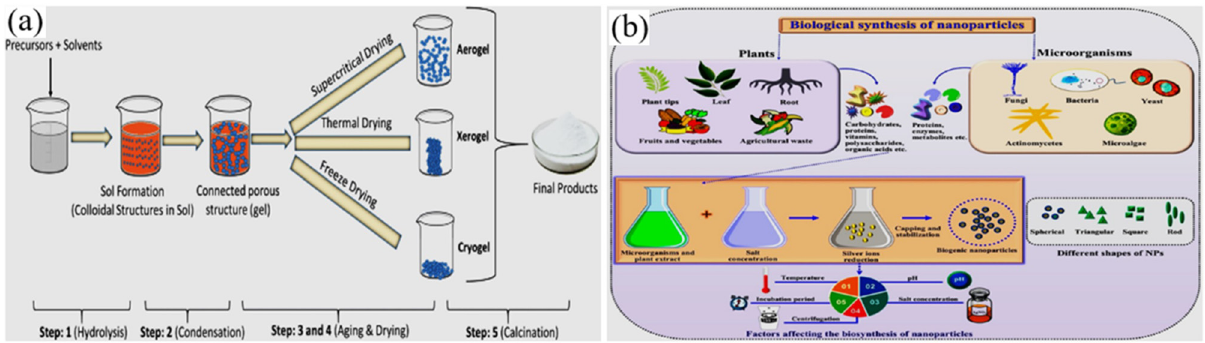
Figure 2: Illustration of ( a ) sol – gel procedure [ 13 ] and ( b ) biosynthesis techniques [ 14 ] for NiNPs